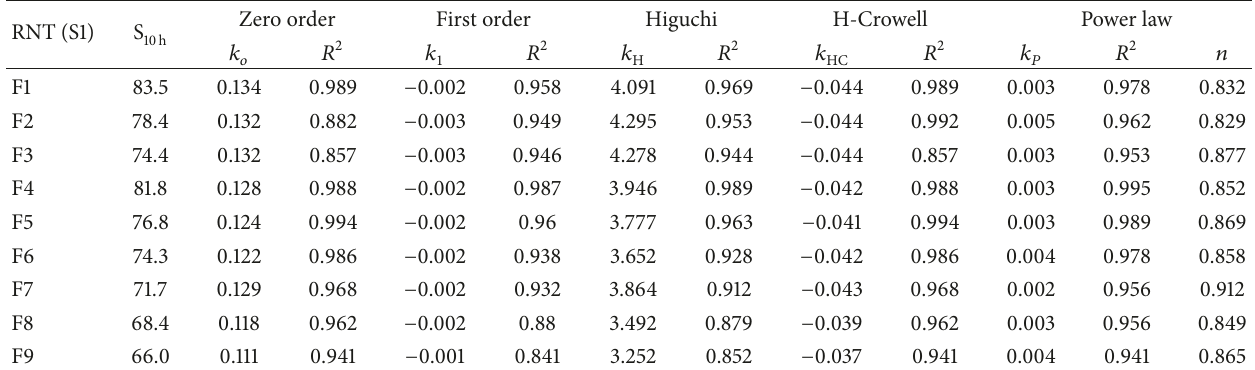
Table 7: DR study for 1st batch matrix tablets.